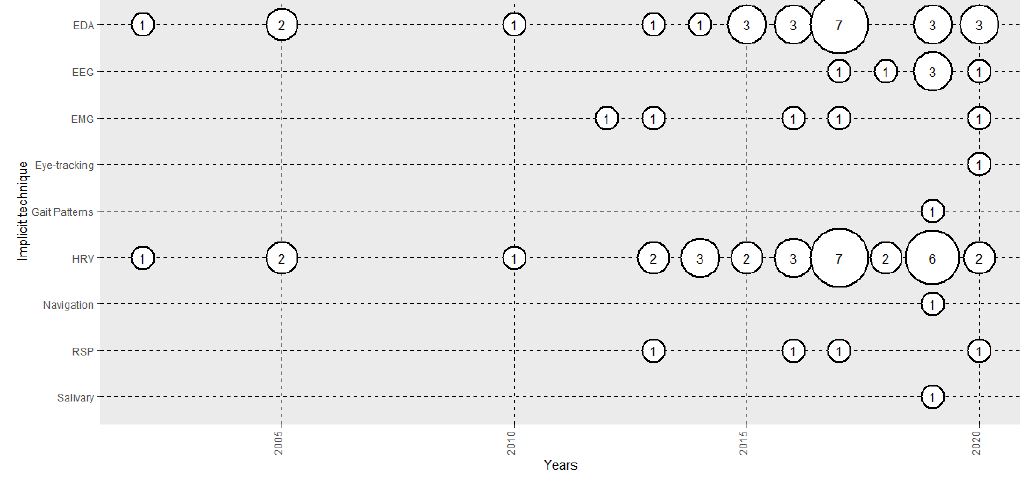
Figure 4. Evolution of the number of papers published each year based on the implicit measure used.